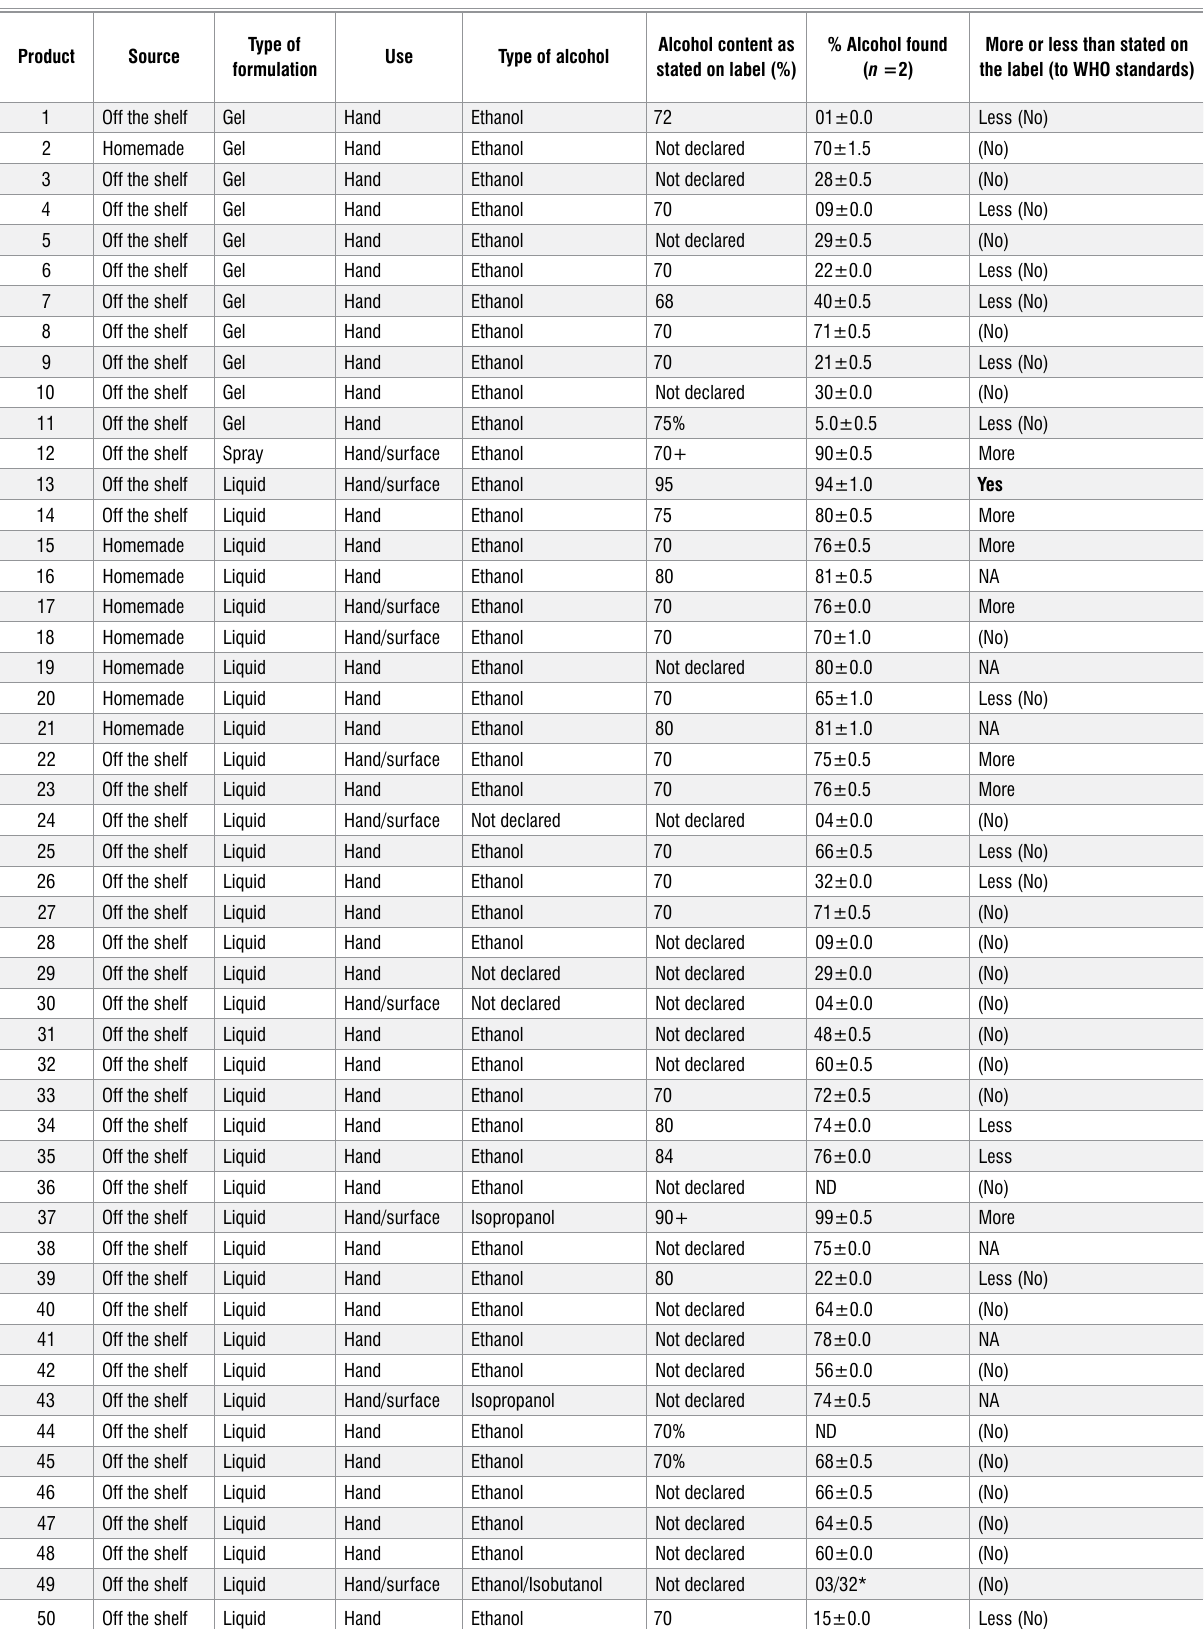
Table 1: Alcohol-based hand sanitiser products, their sources, formulation, use, type of alcohol, declared composition, composition ( n =2), and average composition relative to WHO standards found using gas